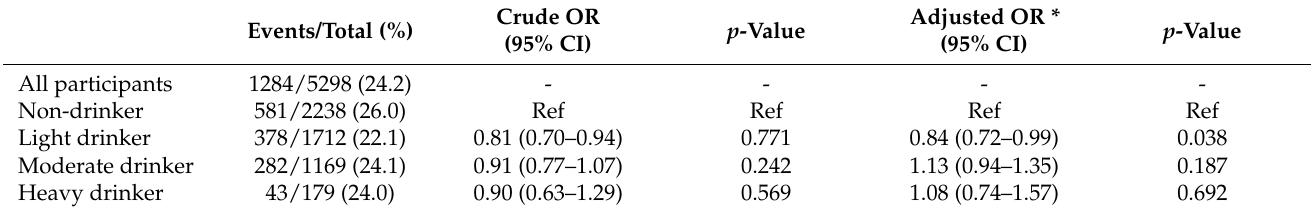
Table 3. The association between alcohol-consumption trajectory classes and newly onset